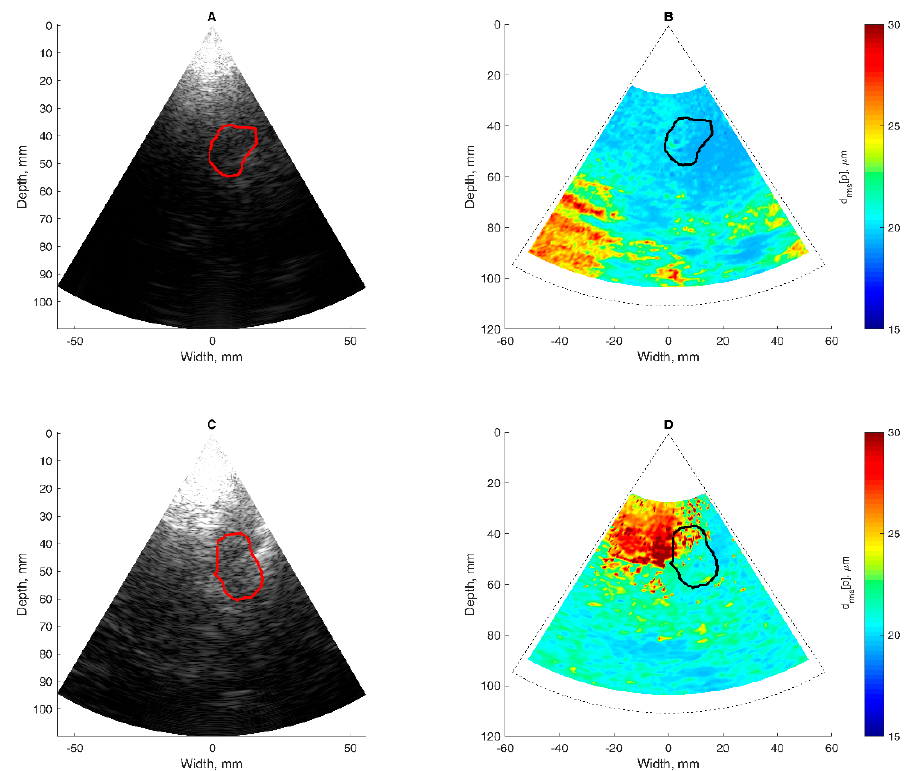
Figure 7. Assessment of endogenous motion in the coronal plane of cranium: ( A , C ) B-mode ultrasound image together with the outlined cross-sectional region of the hippocampus; ( B , D ) map of endogenous motion in the coronal plane of cranium: root mean square of displacement signal d rms [ p ] represented in color scale. Hippocampus region outlined with the solid line. Parts ( A , B ) correspond to the subject with Alzheimer’s disease, parts ( C , D ) to the healthy elderly subject.